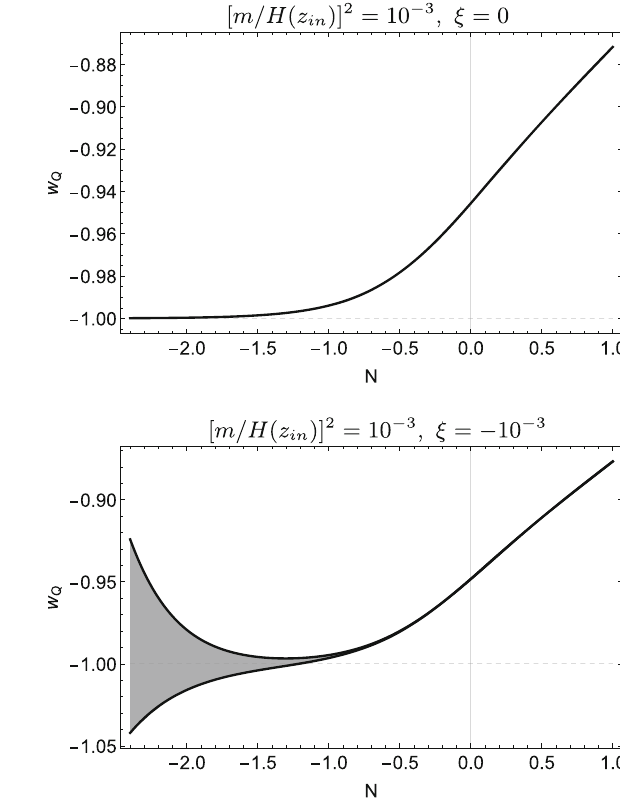
Fig. 4 The DE equation of state parameter w DE ≡ w Q = p Q /ρ Q for the quantum backreaction as a function of N =− ln ( 1 + z ) . To facilitate comparison, the parameters are chosen as in Figs. 2 and 3 and they are indicated above the plots. The uncertainty in the lower two plots reflects the uncertainty related to the subtraction of the part of the quan-